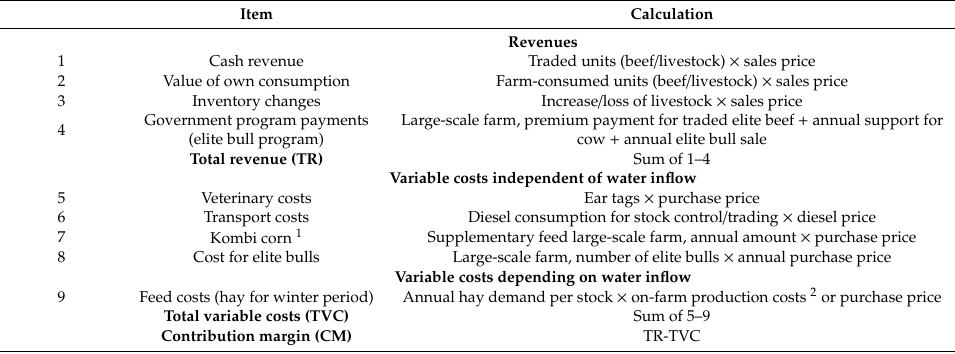
Table 2. Calculation procedure for contribution margin and net farm income from operations in short run (adapted from the work in